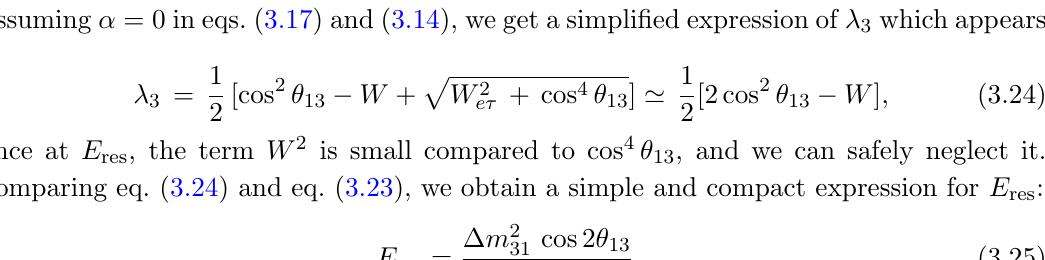
Figure 2 . The variations in the (cid:1) m 2 right panel) with the neutrino energy E in presence of V CC and V give plots for three di(cid:11)erent cases: i) (cid:11) e(cid:22) = (cid:11) e(cid:28) = 0 (the SM case, black solid line), ii) (cid:11) e(cid:22) = 10 (cid:0) 52 , (cid:11) e(cid:28) = 0 (blue dash-dotted line), and iii) (cid:11) e(cid:22) = 0, (cid:11) e(cid:28) = 10 (cid:0) 52 (red dashed